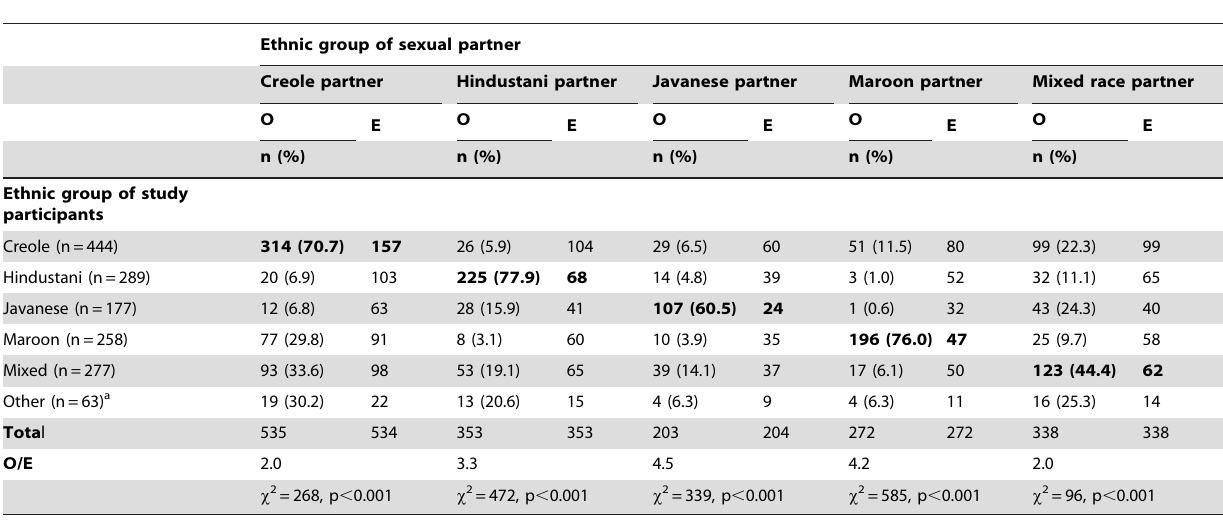
Table 3. Ethnic sexual mixing patterns of men and women, Paramaribo, Suriname, 2008 to